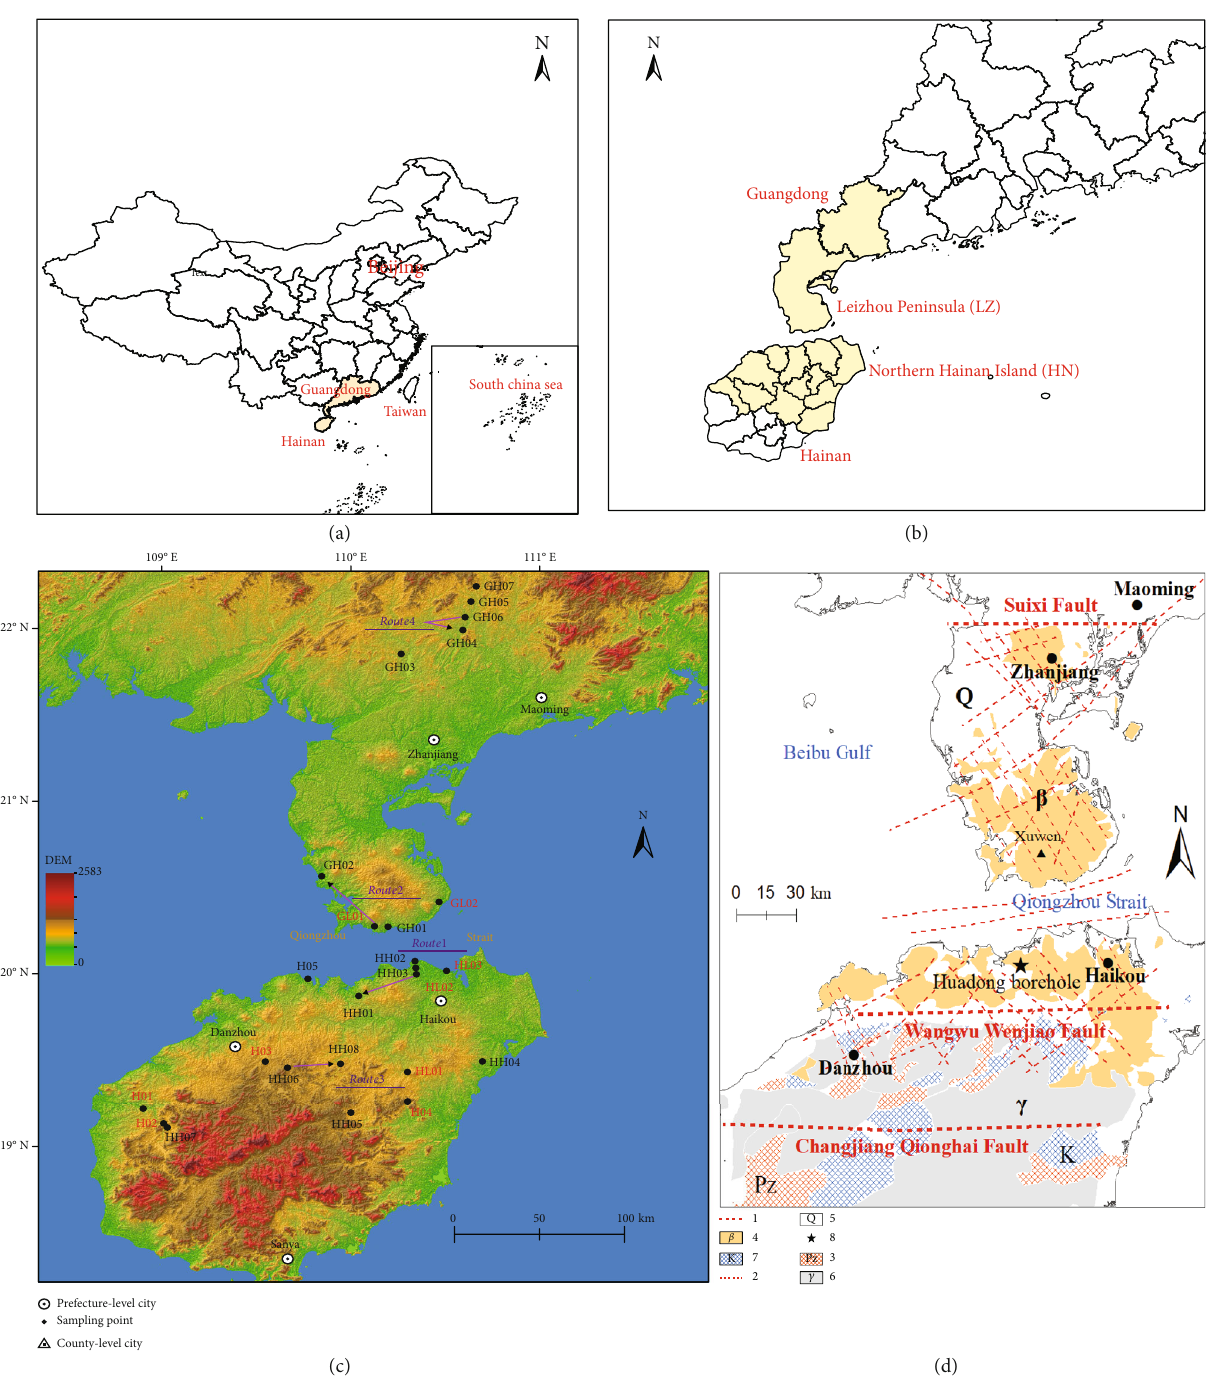
Figure 1: Location and regional geological sketch of the study area. 1-Fault; 2-probable fault; 3 Paleozoic; 4-Cenozoic basalt; 5-Quaternary clay and sand; 6-Mesozoic granite; 7-Cretaceous quartz clastic rock; and 8-4387 m Huadong hot dry rock borehlole, and the drilling temperature is 185 °